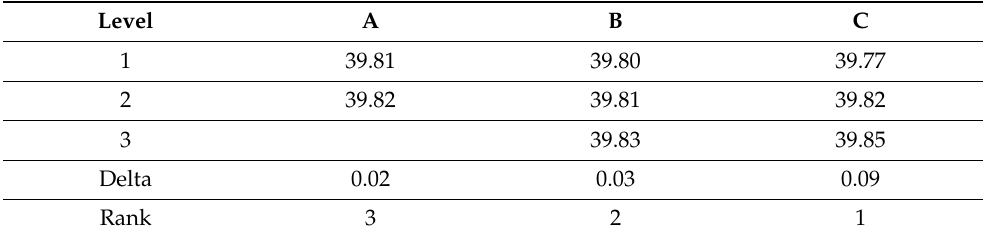
Table 5. Response table for signal to noise ratios for threshing efficiency (larger is better).